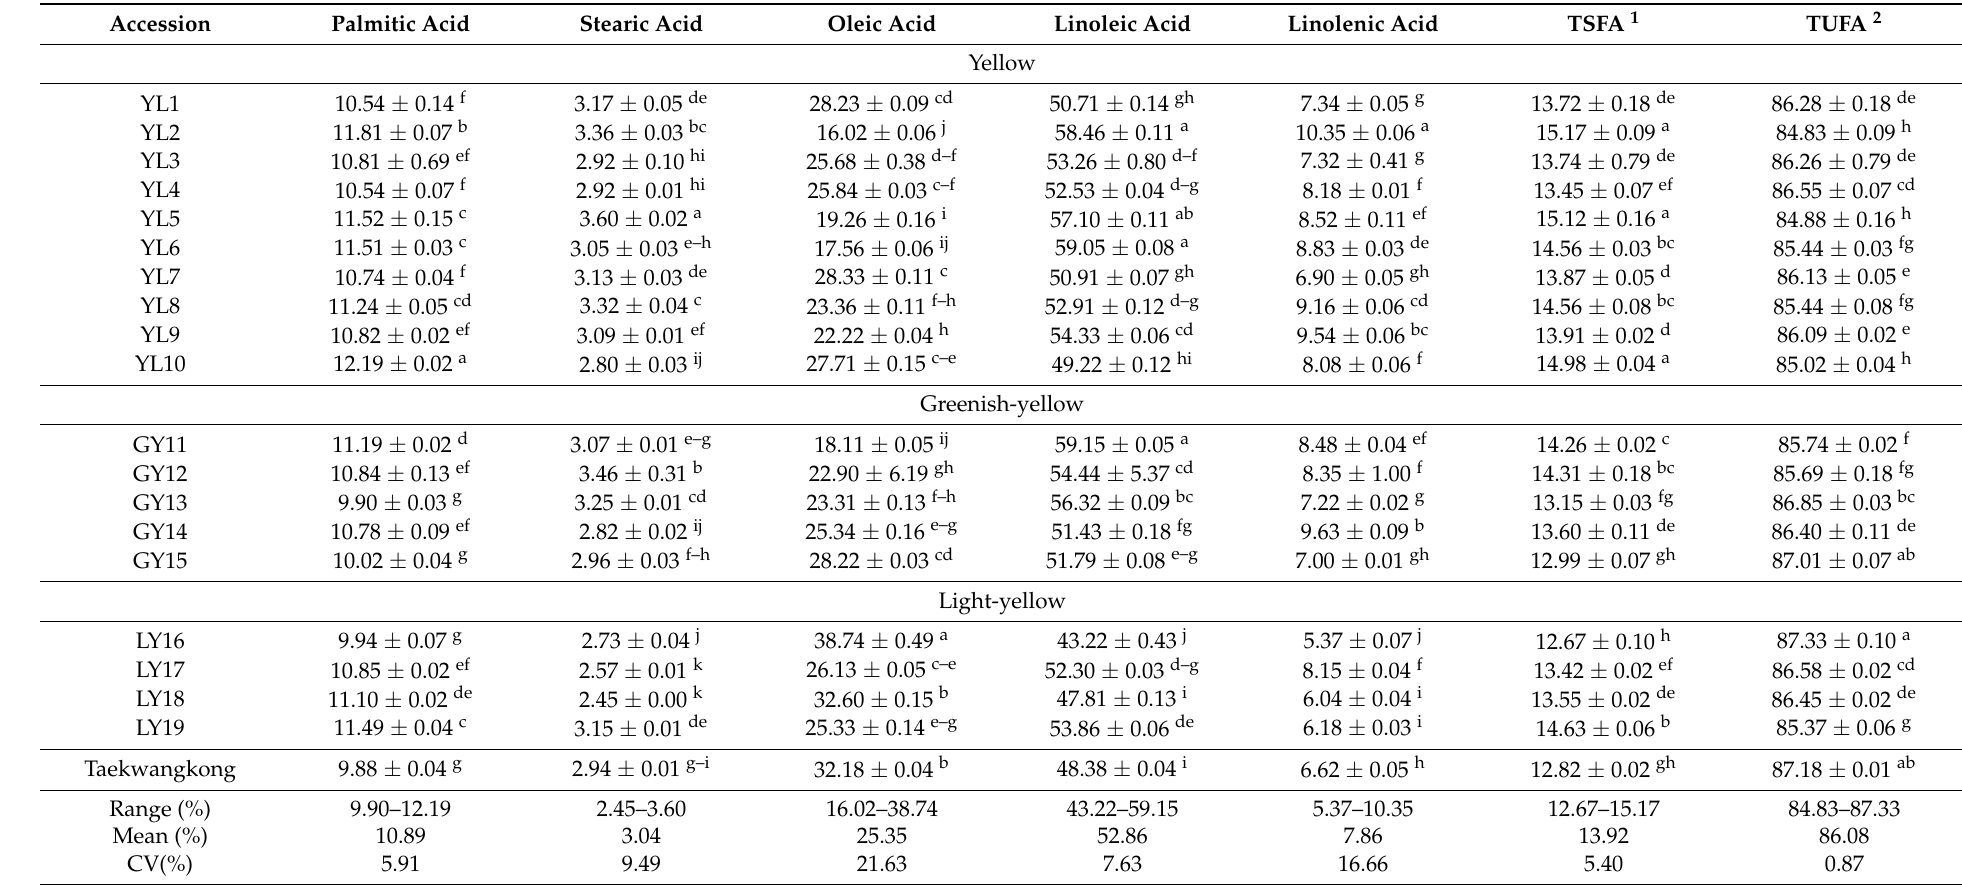
Table 2. Contents (%) of individual and total fatty acids in seeds of the studied